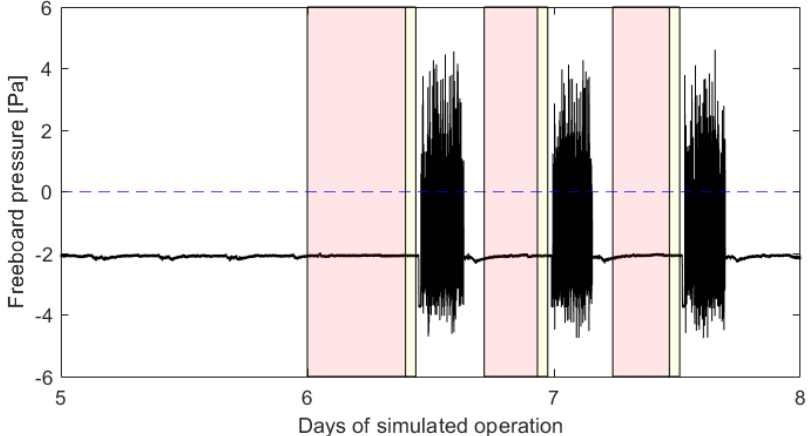
Figure 9. Illustration of observations selected for the target dataset, X t . X t is constructed from observations in the gold-shaded region, but event-preceding patterns may still be present outside this window (red shaded area). The dashed blue line indicates zero gauge pressure.